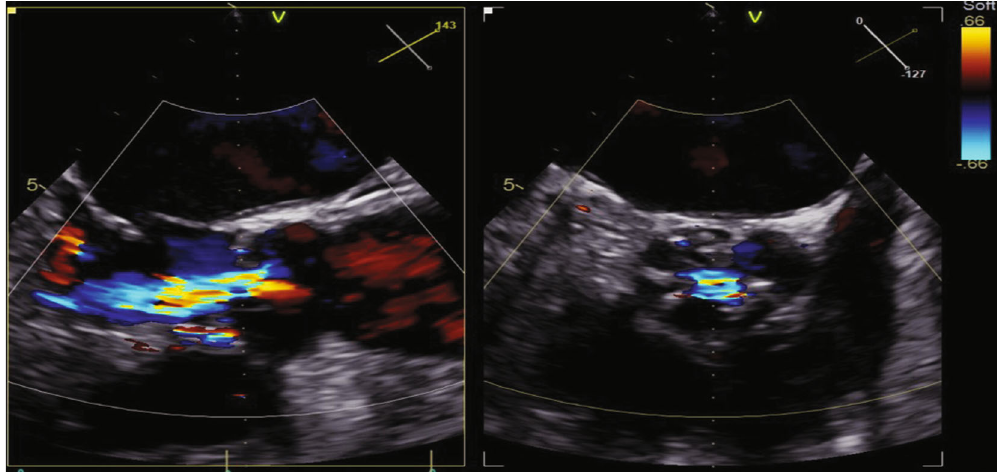
Figure 1: Transesophageal echocardiography image acquired prior to TAVR demonstrating thickened aortic valve with signi fi cant central aortic regurgitation without evidence of vegetation or